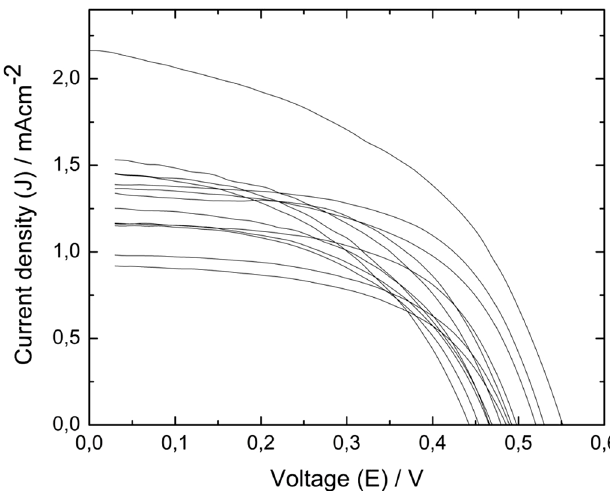
Fig. 1. Current density vs potential pro fi les for all the cells assembled in the DSSC panel.